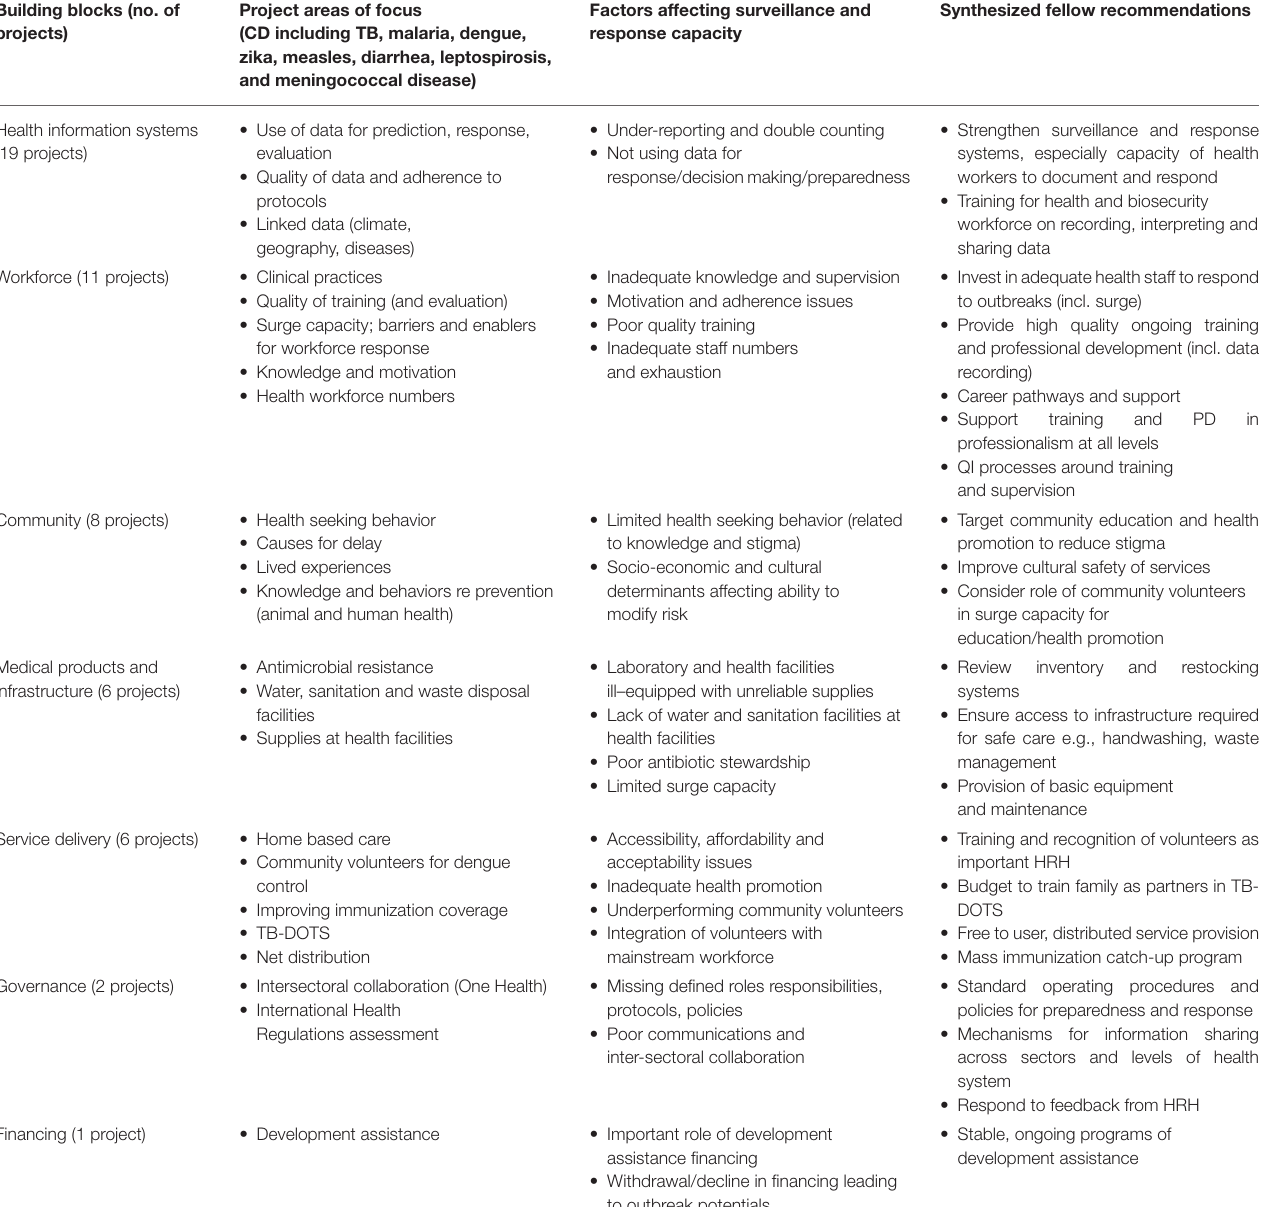
TABLE 2 | Project areas, health system building blocks, factors affecting health system capacity, and recommendations from Research Fellows. Building blocks (no. of